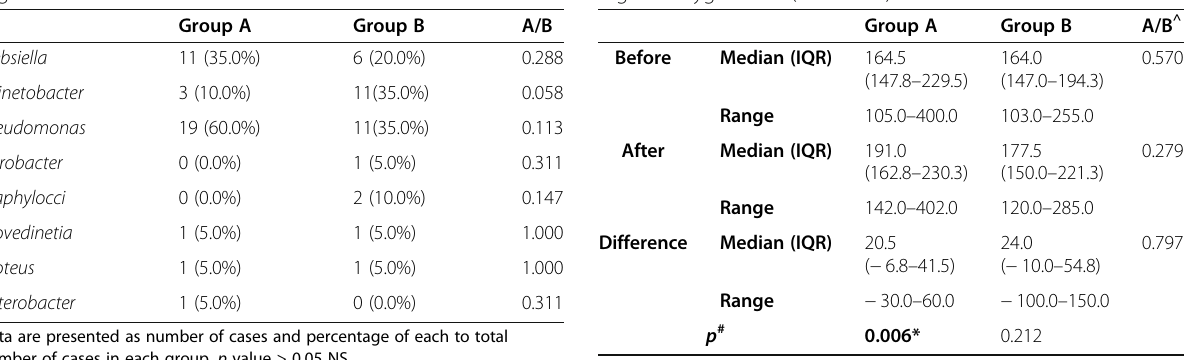
Table 5 Comparison between case and control groups as